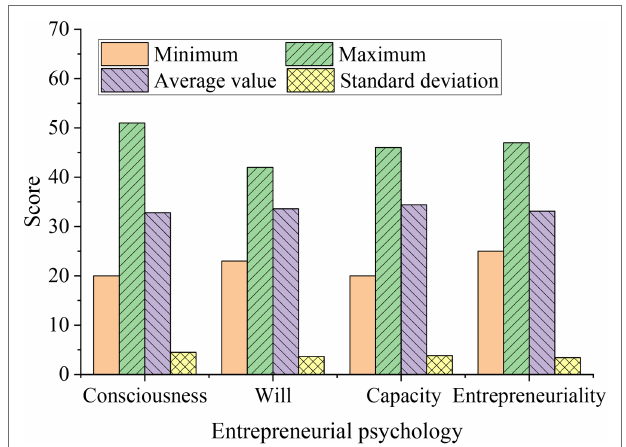
FIGURE 2 | Overall situation of College Students’ entrepreneurial psychology.